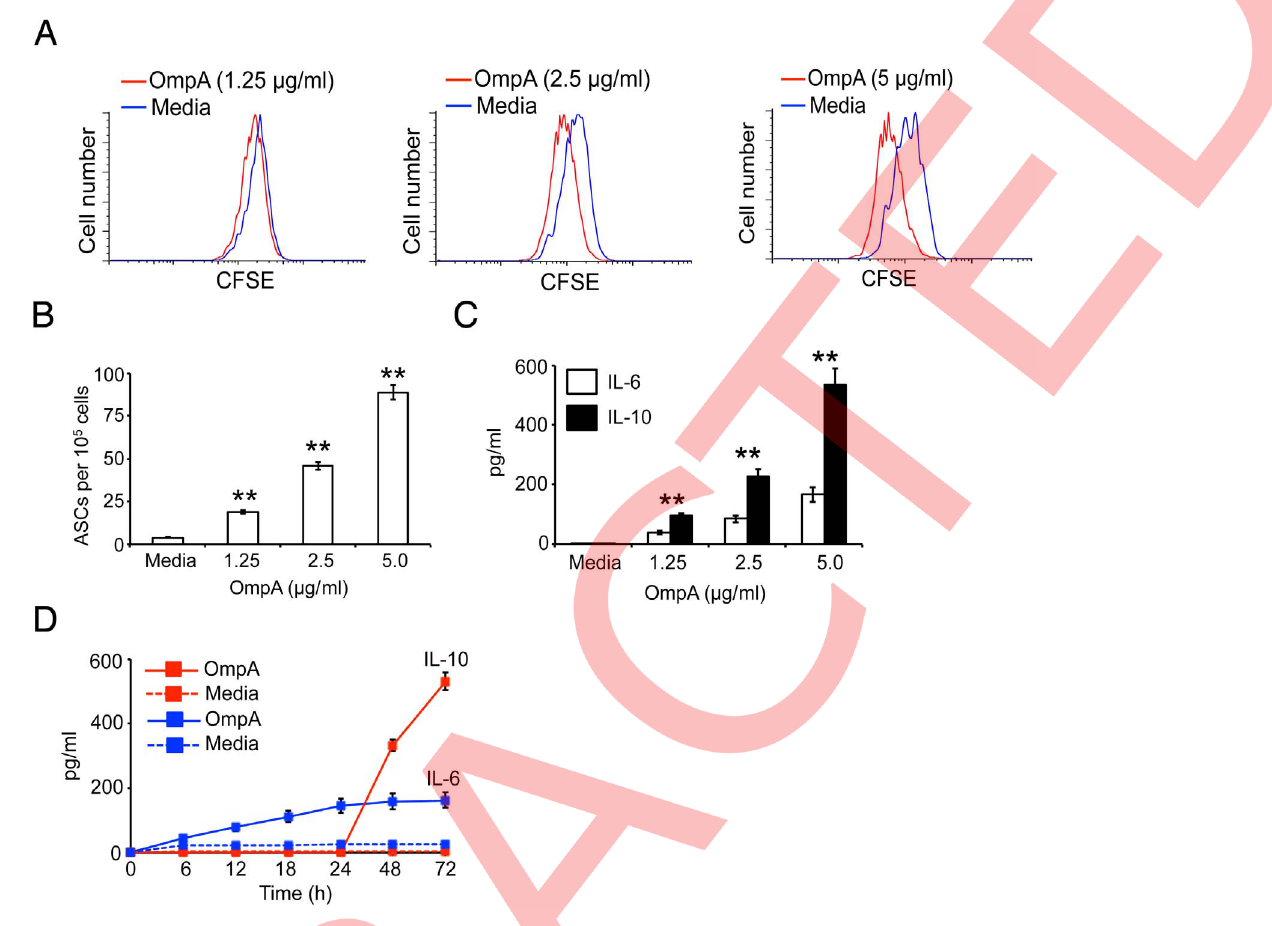
Figure 4. OmpA evokes proliferation and differentiation of splenic B cells as well as induces secretion of IL-10 and IL-6. ( A ) CFSE- labeled B cells were cultured in medium alone or with an increasing concentration of OmpA for 96 h followed by flow cytometry. A representative of three independent experiments is shown and each experiment was done in triplicate. ( B ) The total number of ASCs (IgM + IgG-secreting cells) was analyzed by ELISPOT at the end of a 72 h culture period. Results are expressed as numbers of ASCs/10 5 cells seeded and correspond to the mean 6 S.E.M of quadruplicate determinations. **, p , 0.01, relative to the untreated (media alone) group. ( C ) Purified splenic B cells were cultured in the absence or presence of indicated concentrations of OmpA for 72 h. The culture supernatants were assayed for IL-6 and IL-10 by enzyme-linked immunosorbent assay. The values are derived from IL-6 and IL-10 standard curves and represent the mean 6 S.E.M of three independent experiments performed. **, p , 0.01, relative to the untreated (media alone) group. ( D ) Time kinetics of IL-6 and IL-10 production by B cells incubated without or with OmpA (5 m g/ml). The values are derived from IL-6 and IL-10 standard curves and represent the mean 6 S.E.M of three independent experiments performed. **, p , 0.01, relative to the untreated (media alone)